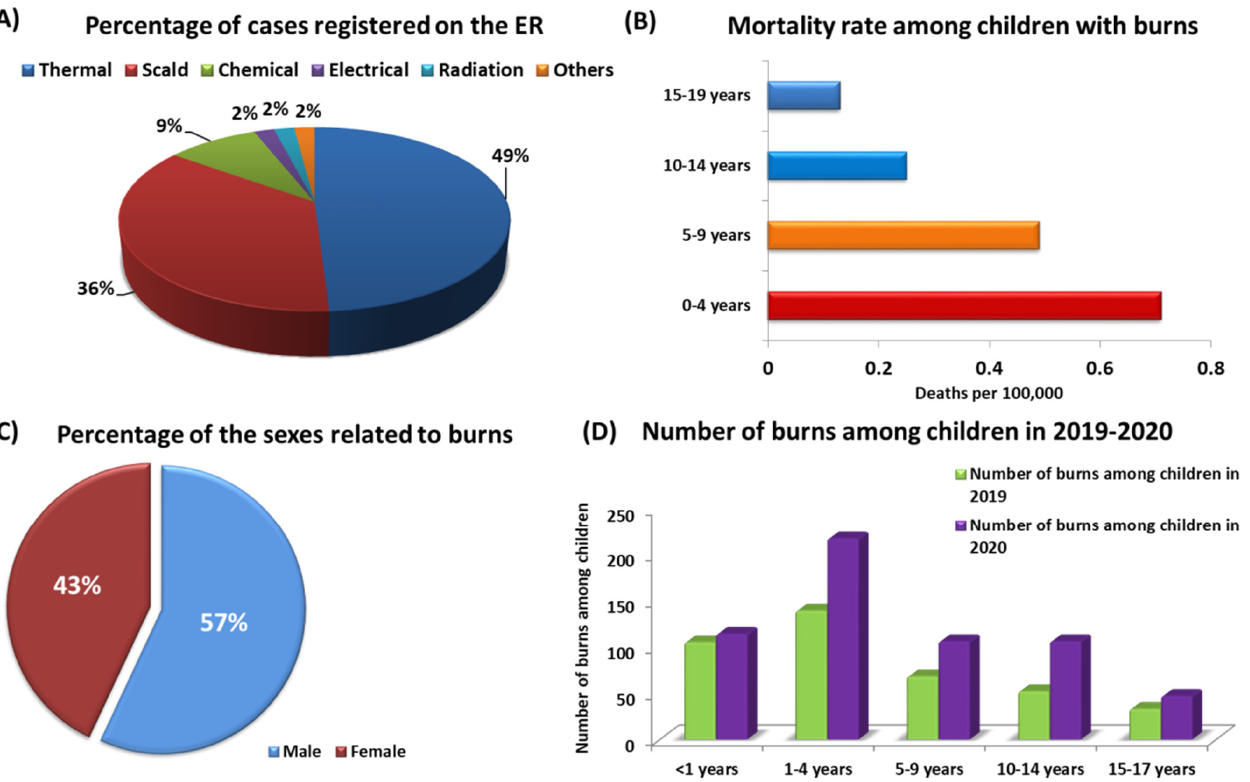
Figure 1. Statistics of burns among children: ( A ) percentage of burns recorded in the ER, including the cause of the injury; ( B ) child mortality rate as a result of burns by age category; ( C ) percentage of burns by patient’s sex; ( D ) number of burns among children in 2019–2020, taking into account age categories based on [16,18,22].